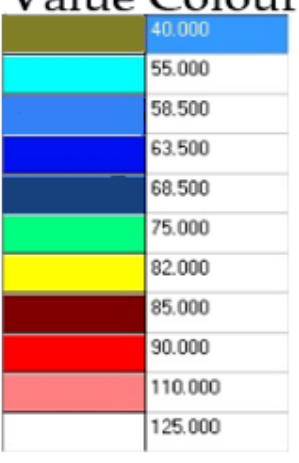
Figure 13. Line fill method.